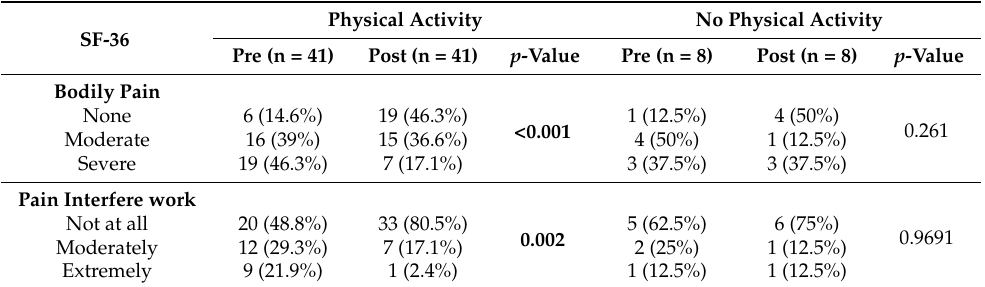
Table 4. Bodily pain and pain interfere work of SF-36 at 3-week